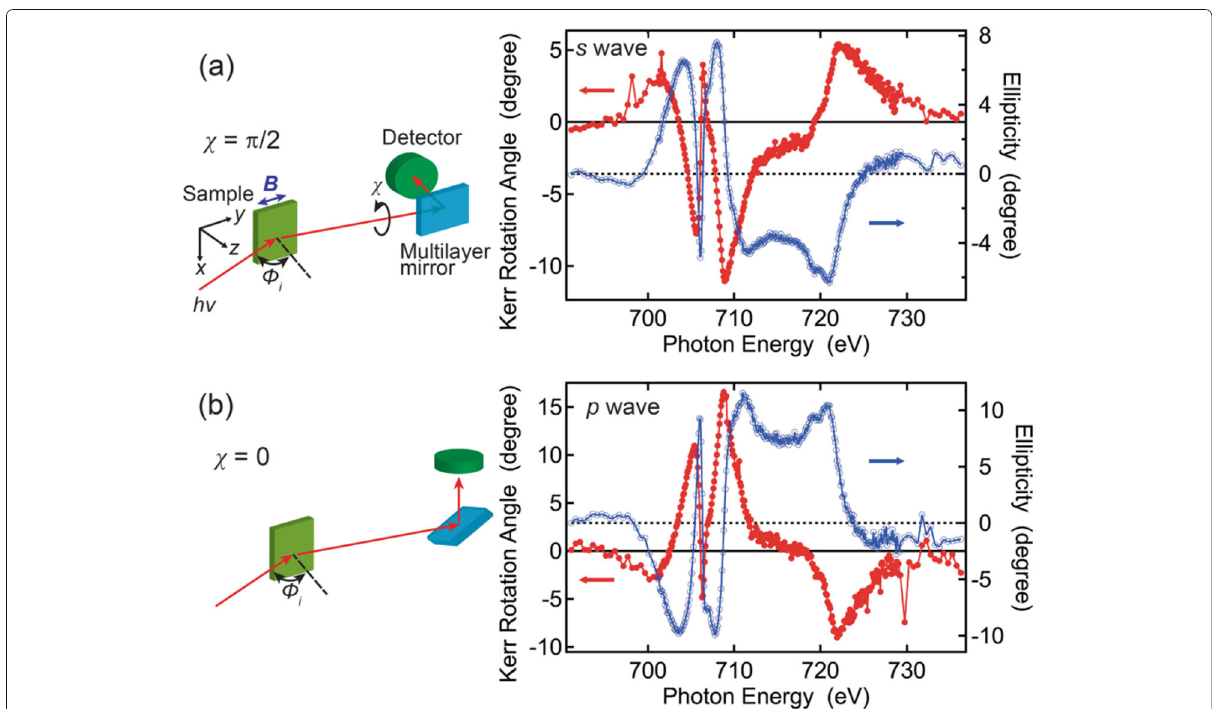
Fig. 25 Simultaneous experiments of soft X-ray MOKE and MCD [32]. Geometries and results of L-MOKE measurements of an Fe nanofilm at the L 2,3 -edge using the polarization-modulated light at the configuration of a the s-wave and b the p-wave. Solid (red) circles and open (blue) circles represent the spectra of θ K (left axis) and (cid:15) K (right axis),